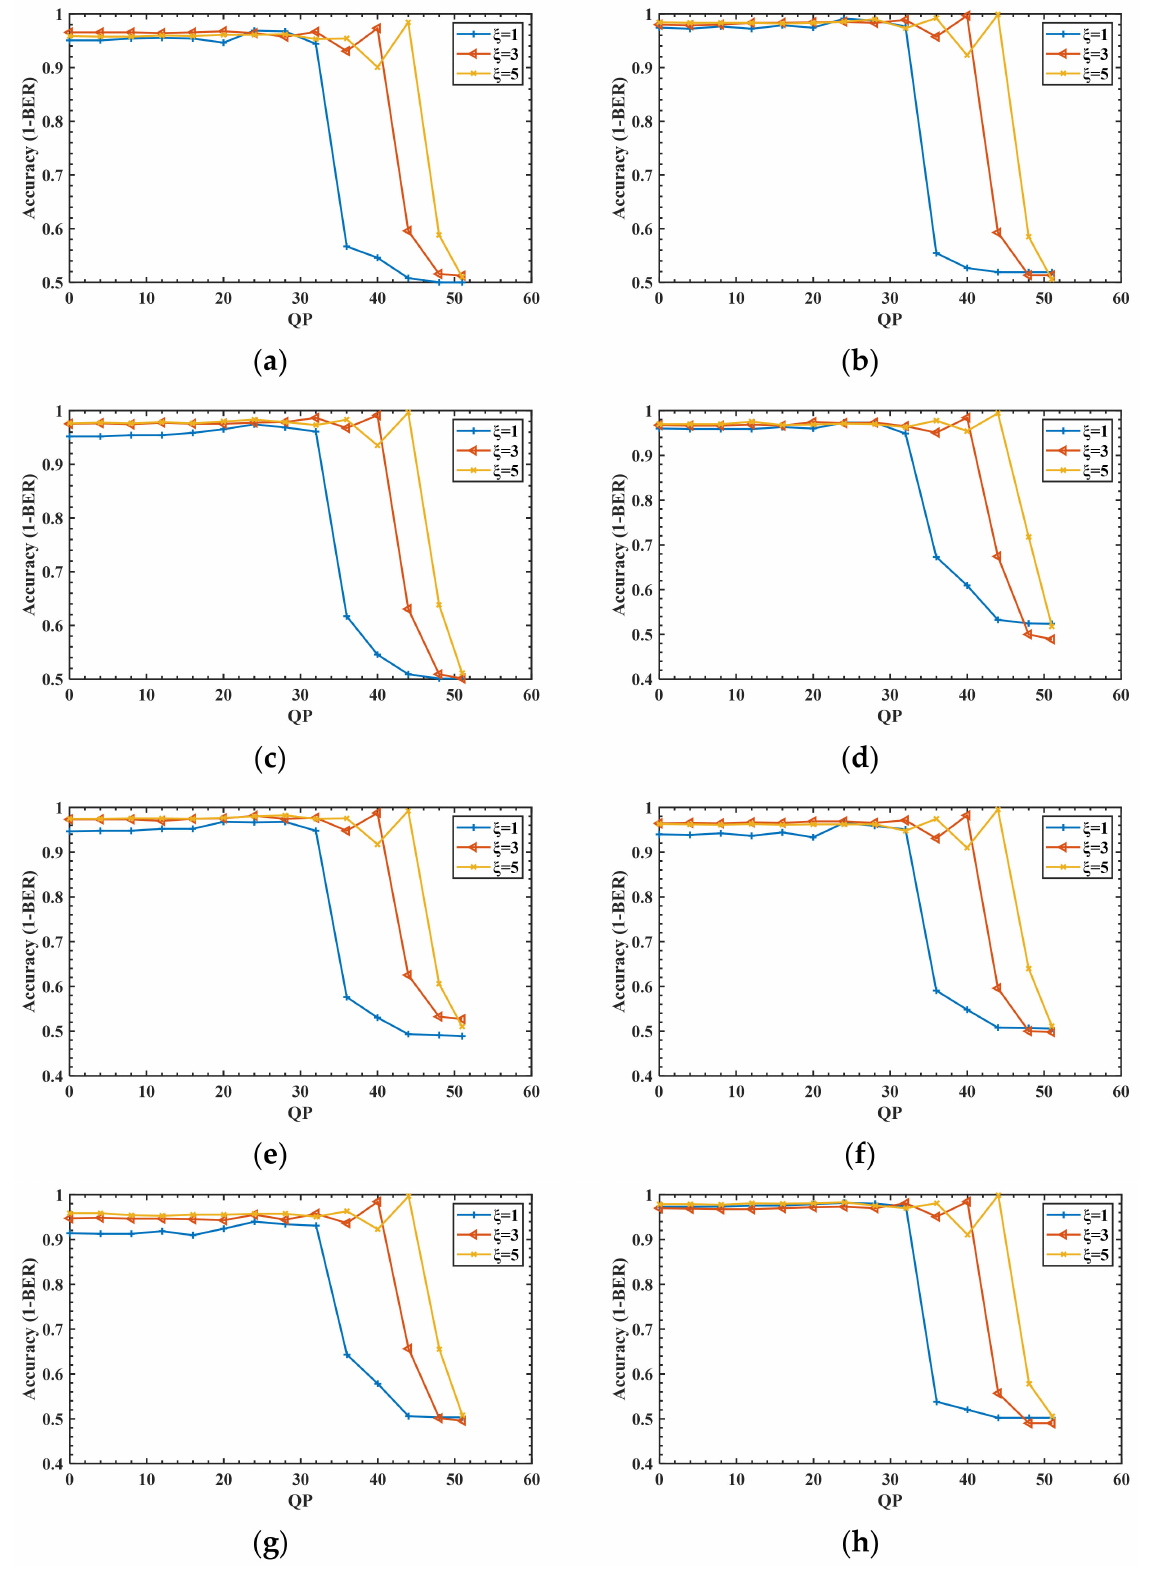
Figure 9. Accuracy of information extraction of different ξ . ( a ) container, ( b ) foreman, ( c ) salesman, ( d ) mobile, ( e ) carphone, ( f ) news, ( g ) city, ( h )